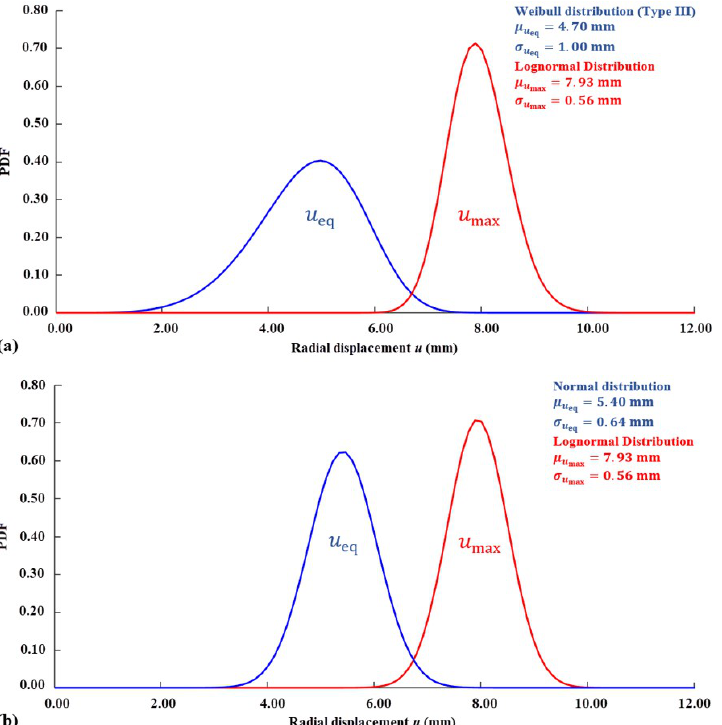
Figure 10. Demand and resistance histograms, generated using 5E+06 Monte Carlo simulations: (a) Tunnel A; (b) Tunnel B.